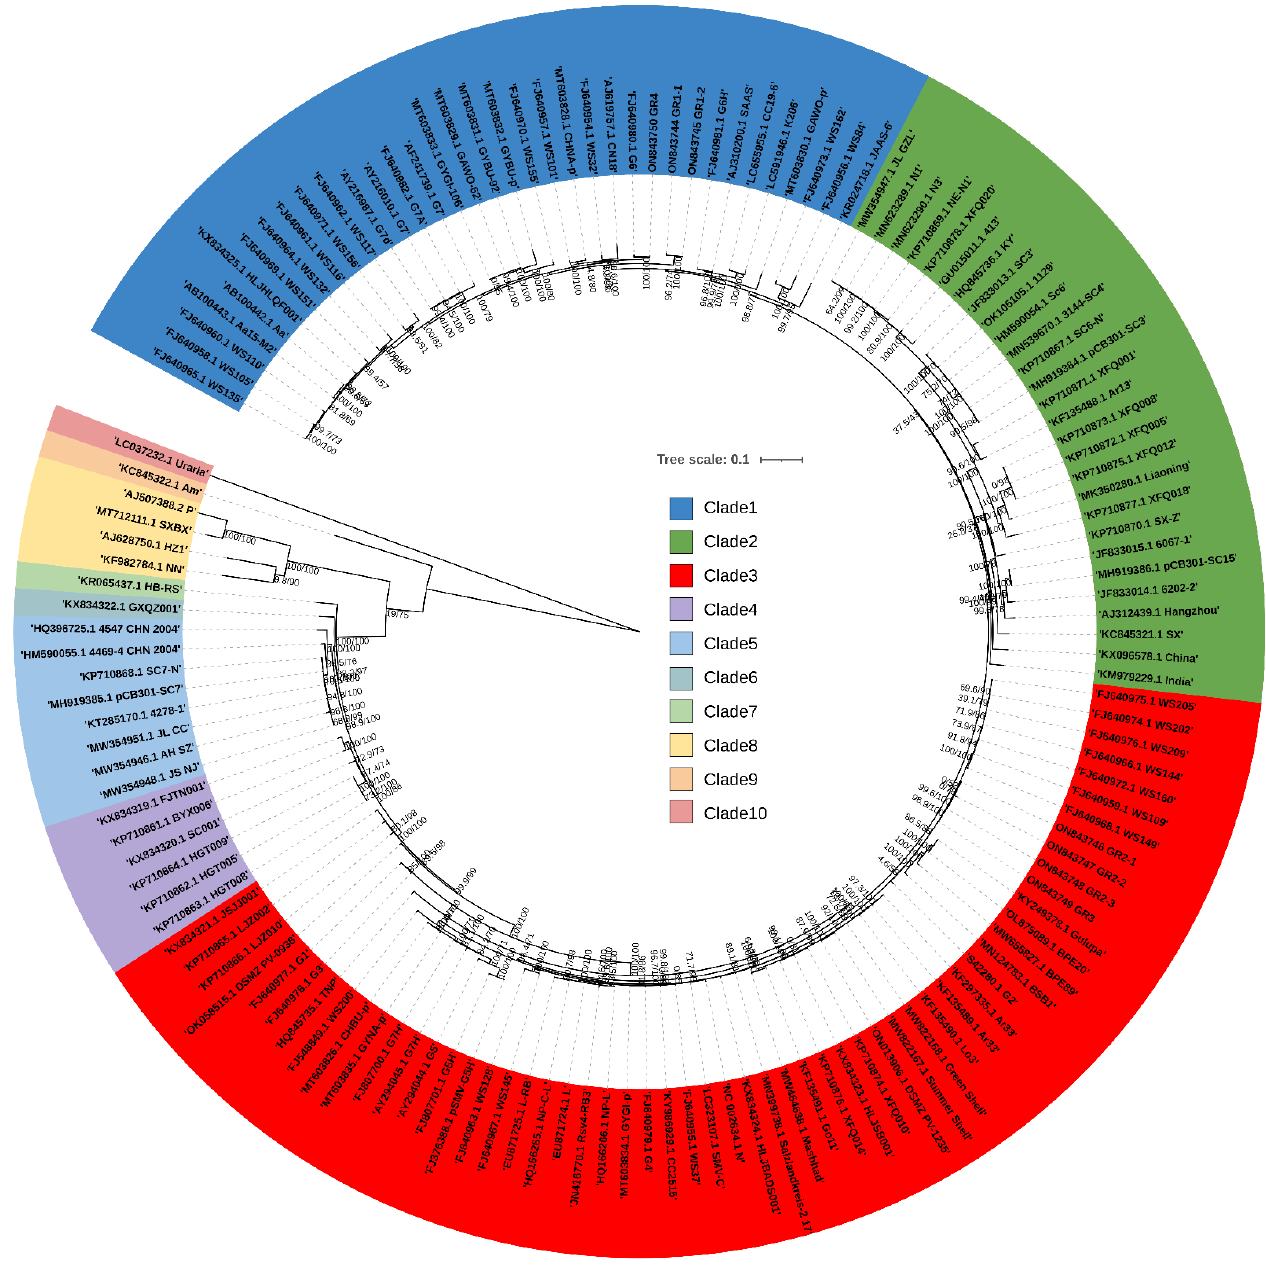
Figure 2. Phylogenetic tree of 143 SMV genomes constructed based on complete coding DNA sequences, generated using the maximum likelihood method. A total of 143 sequences with 9805 sites covering whole coding DNA sequences were used for phylogenetic tree construction using IQ-TREE with GTR + F+I + G4 for the best-fit model. The accession number and isolate (strain) name for each SMV genome are indicated. Both SH-aLRT and UFBoot support values are indicated on the branches. A total of 10 clades were found, and they are shown in 10 different colors. The isolate Uraria (GenBank LC037232.1) in clade 10 was used as an outgroup. Detailed information for individual SMV genomes can be found in Table S1.